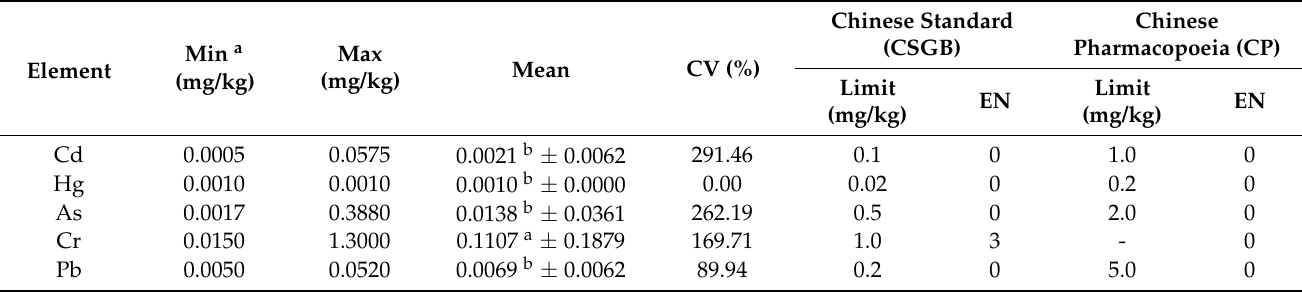
Table 3. The statistics of heavy metal concentrations in coix